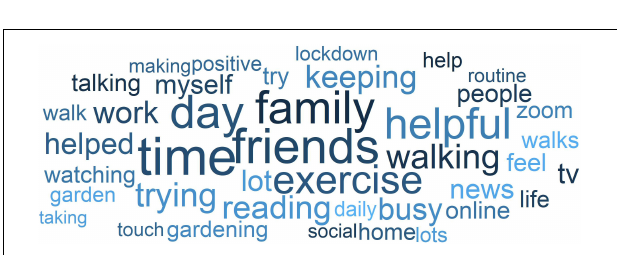
FIGURE 2 | Word cloud. Forty most frequently used words across responses. Words sized according to number of responses they appear